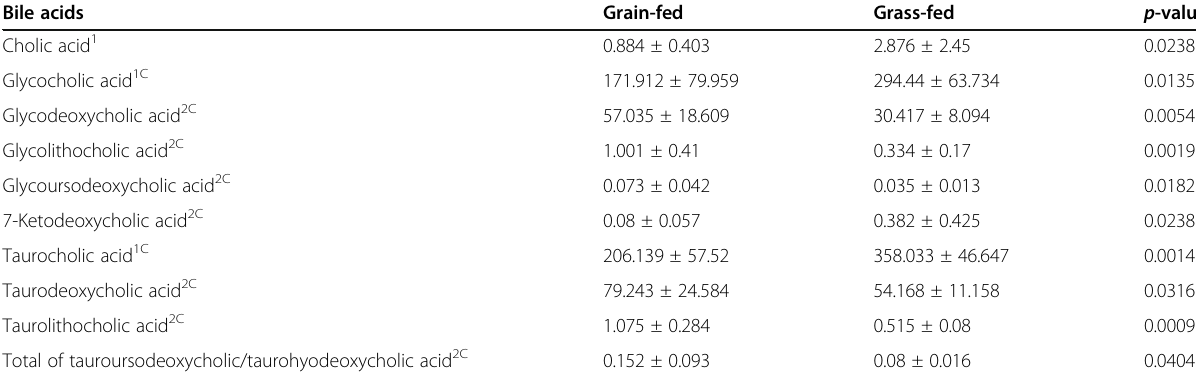
Table 3 Ten bile acids with significant different levels between grass-fed and grain-fed cattle (concentration unit: μ mol/ml) Bile acids